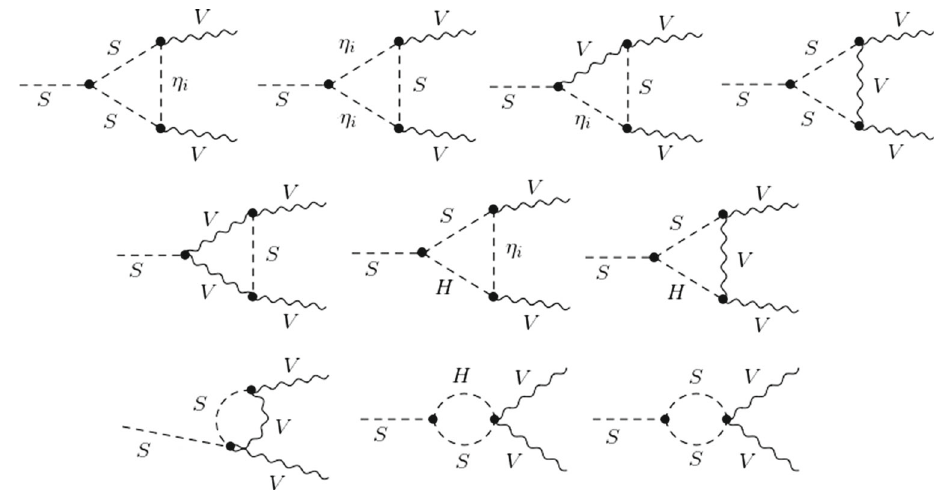
Fig. 10 NLO S field contributions to the SV V vertices